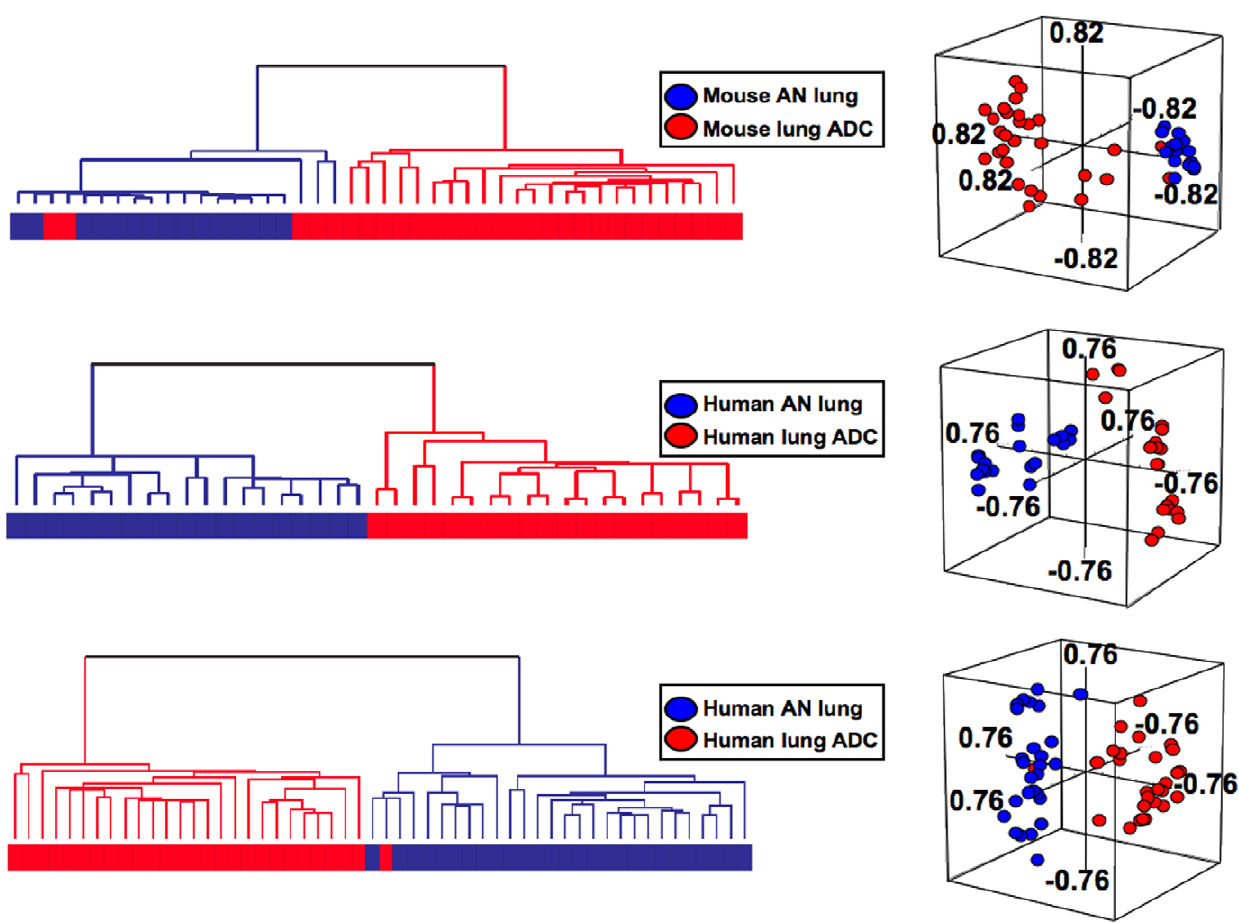
Figure 8. The mouse NNK-ADC expression signature effectively separates both mouse and human lung adenocarcinomas from their adjacent normal counterparts. A . Dendogram (left) of hierarchical cluster analysis and PCA (right) of the gene features (n=1452) of the NNK-ADC signature that are present in the Affymetrix MG-U74Av2 platform and gene expression data of mouse normal lung (n=15) and adenocarcinoma (n=29) tissue from the study by Stearman et al [30]. Dendograms (left) of hierarchical cluster analysis and PCA (right) of human datasets including 20 lung adenocarcinomas and 19 adjacent normal lung samples from the study by Stearman et al ( B ) and 27 lung adenocarcinomas and 27 paired adjacent normal lung from the study by Su et al [29] ( C ) and using only orthologous genes of the signature and found in the Affymetrix MG-U95Av2 ( B , n=1877) and HG-U133A ( C , n=2475) platforms.